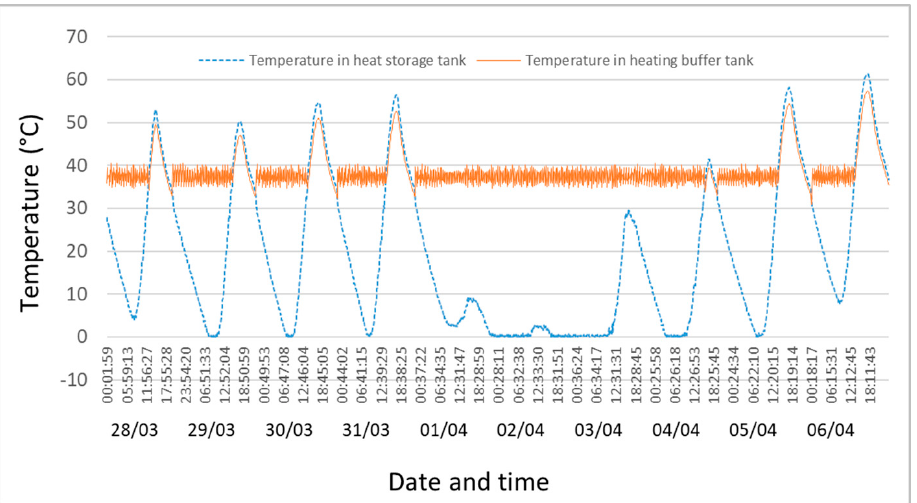
Figure 6. Water temperature in the heat storage tank and the heating buffer tank between 28 March